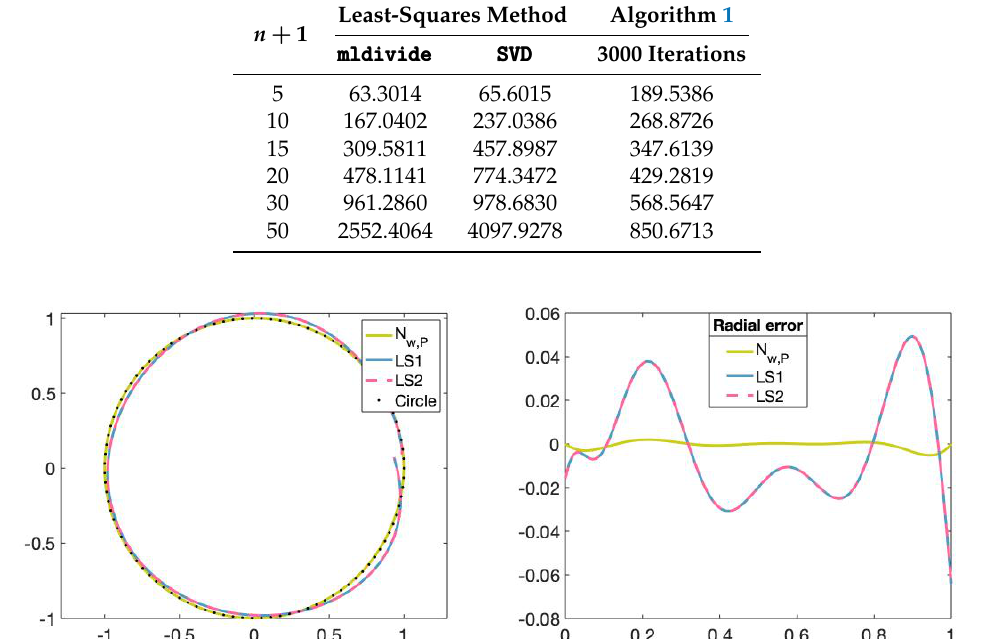
Figure 15. ( Left ): Set of data points on circle (dotted), fitting curve of degree 5 obtained with the neural network, fitting curve of degree 5 obtained with the least-squares method by using the Matlab commmand mldivide (LS1), fitting curve of degree 5 obtained with the least-squares method by using the Matlab command SVD (LS2). ( Right ): The x -axis represents the parameters t in [ 0,1 ] and the y -axis represents the radial error value of the fitting curves obtained with the different methods.